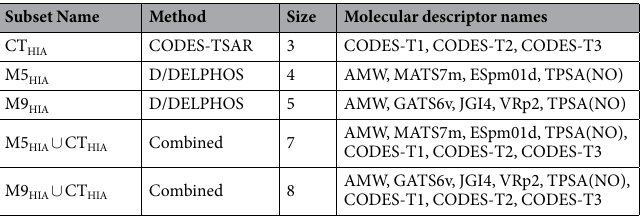
Fig. 5 CODES-TSAR descriptor edges are purple meaning high mutual information, but each one (CODES-T1, CODES-T2 and CODES-T3) presents low entropy with the other M5 HIA descriptors (light pink and pink). This fact demonstrates the complementary information provided by both subsets, M5 HIA and CT HIA . The best classification QSAR model was obtained using the M9 HIA subset. This model achieves the highest accuracy (86.96%) and an elevated average ROC area (0.865). For the HIA classification experiments, two classes were defined: not absorbed molecules and absorbed molecules (see discretization thresholds in Materials and